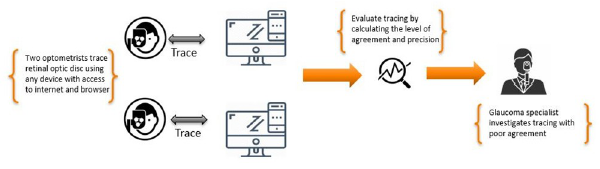
Fig 1. Tracing and data collection flow adopted in this